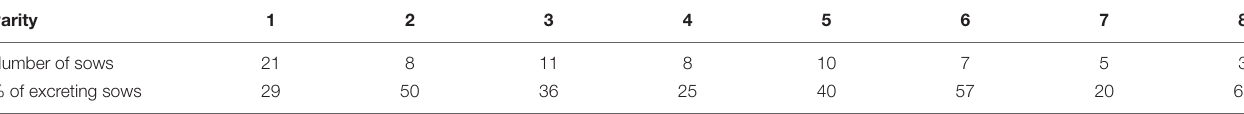
TABLE 1 | Number of sows sampled in each parity and their Salmonella shedding status.